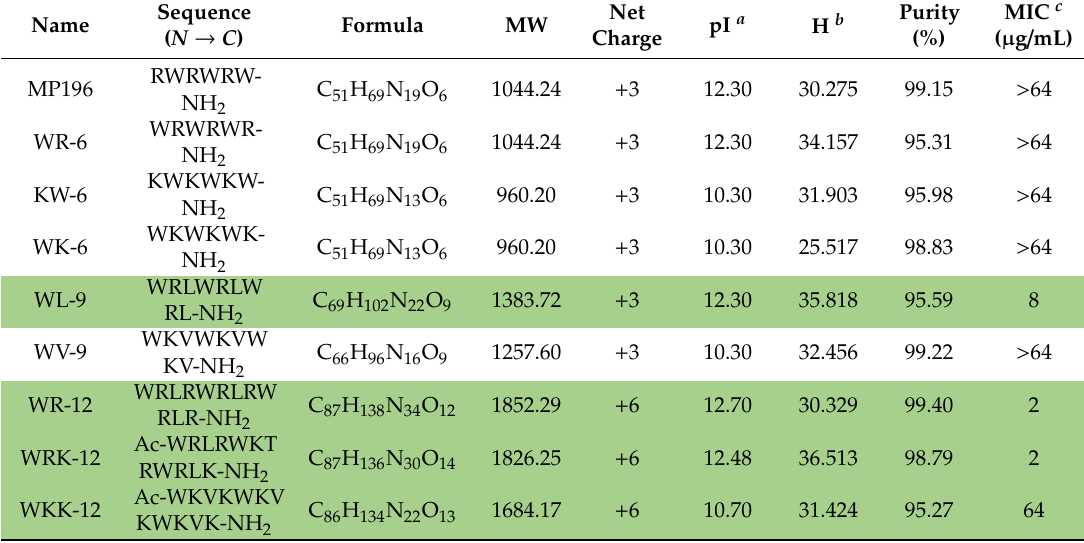
Table 1. Design of tryptophan-rich amphiphilic peptides and their key physicochemical